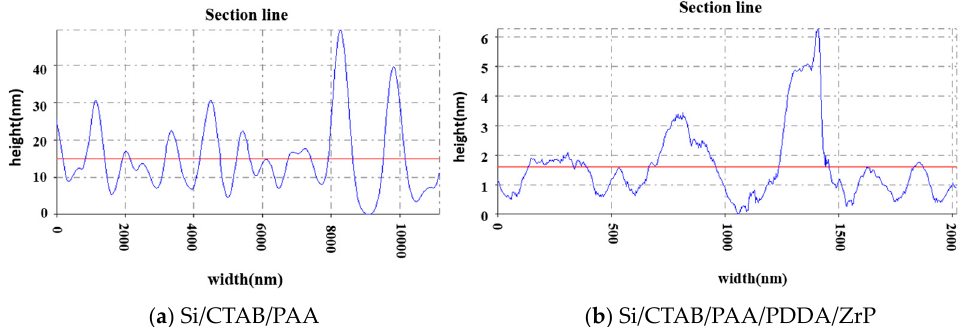
Figure 10. Roughness of silicon wafer coated with PAA ( a ) and with PAA/PDDA/ZrP ( b ), the solid blue line is the contour line, the solid red line is the centerline.